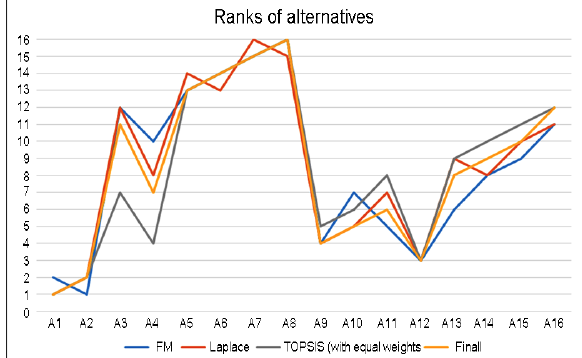
Fig. 5. Ranks of alternatives when are not included weights of